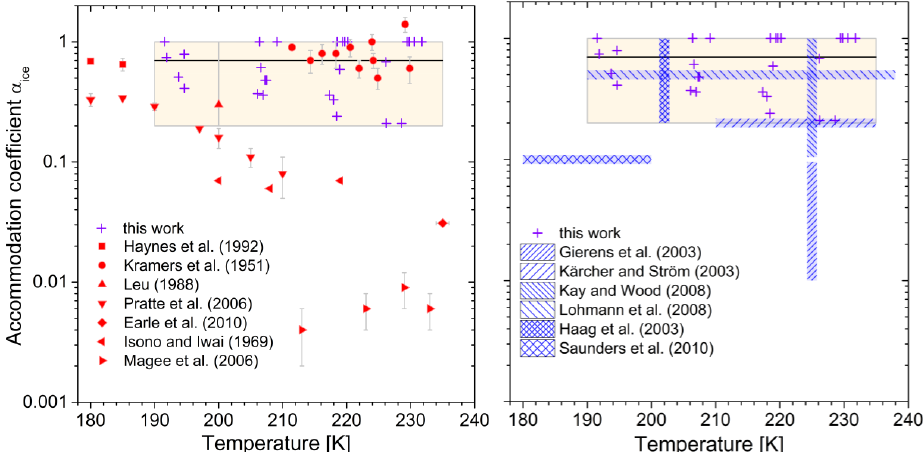
Fig. 7. Comparison of the combined SIGMA and ACPIM result α ice = 0 . 7 + 0 . 3 − resulting from the AIDA cirrus cloud experiments (purple crosses, cf. Fig. 6) between 190K and 235K with literature data from laboratory measurements (red symbols, cf. Table 1) and cirrus cloud model studies (blue bars, cf. Table 2). Error bars are included when given in the original publication. For the cirrus cloud model studies, the bars indicate the range of preferred α ice values at one temperature or the preferred α ice value within the considered temperature range, respectively.